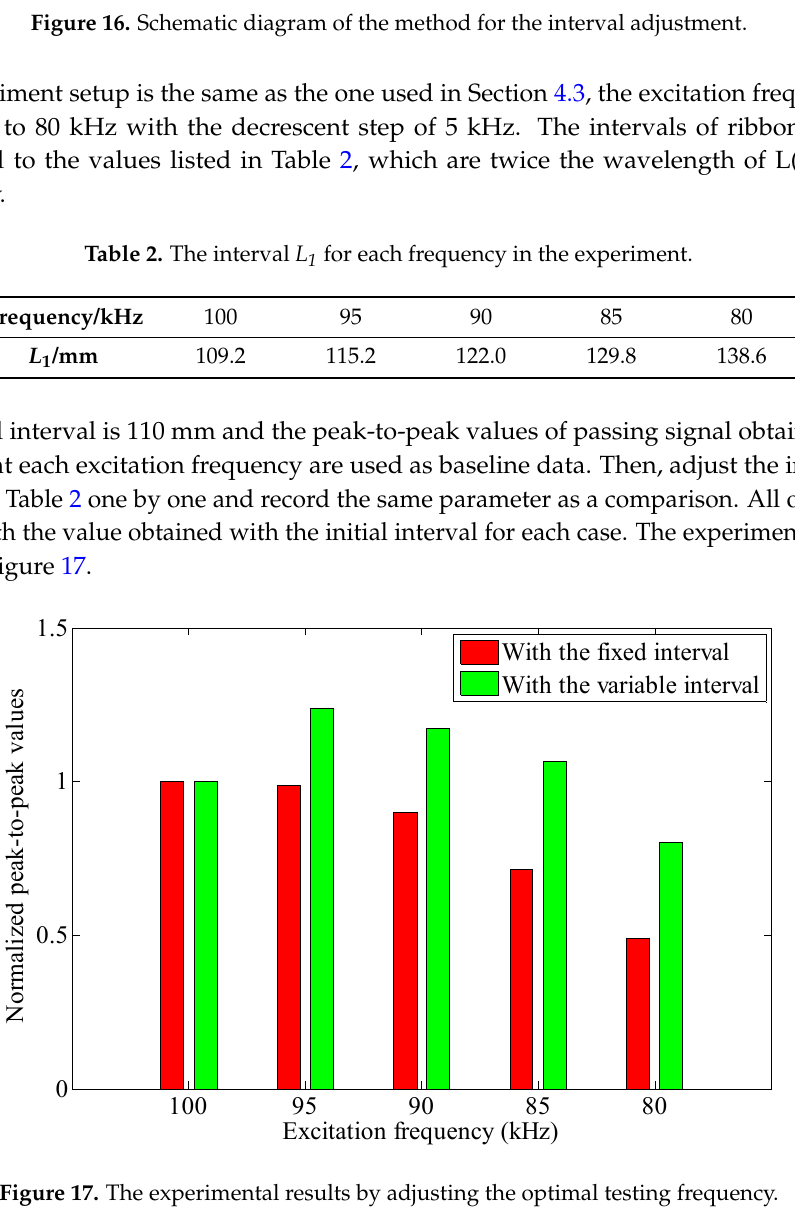
Figure 17. The experimental results by adjusting the optimal testing frequency.